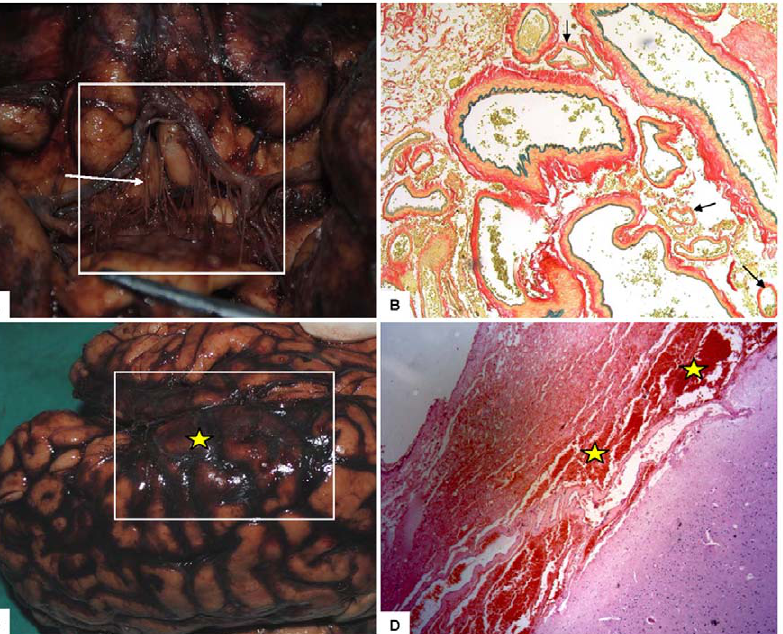
Figure 3. Macroscopical and microscopical findings at autopsy. A: malformation of the vascular network around the proximal middle cerebral artery (white arrow); B: fine vascular network indicated by black arrows (Ponceau/Victoria blue staining, 6 100); C: subarachnoid hemorrhage in the right parieto-temporal area; D: subarachnoid hemorrhage in right parietal lobe (H&E staining, 6 100); yellow stars indicate the hemorrhagic area.